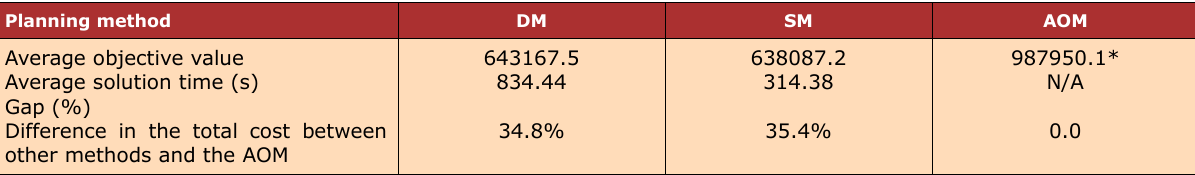
Table 1. Comparison of different